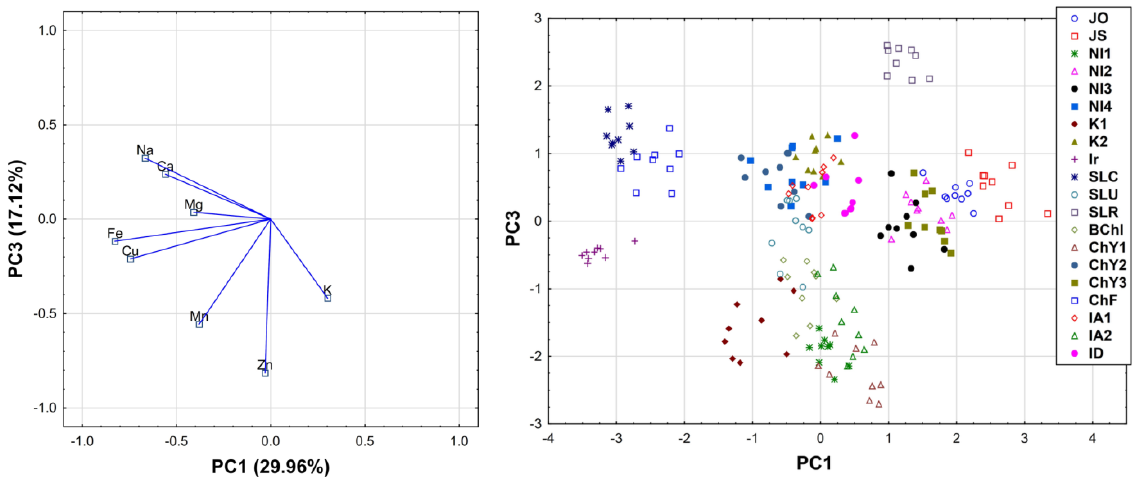
Figure 2. Loadings (on the left ) and scores (on the right ) of first and third components of principal component analysis (PCA).